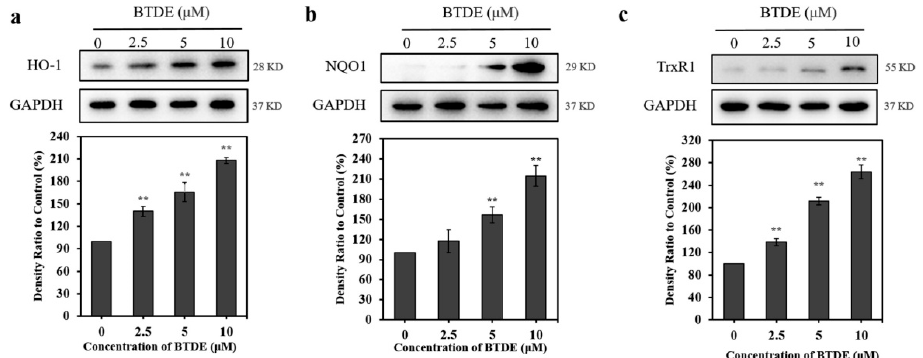
Figure 6. BTDE increases the expression of HO-1, NQO1, and TrxR1. HaCaT cells were treated with BTDE (2.5–10 μ M) for 24 h. The expression levels of HO-1 ( a ), NQO1 ( b ), and TrxR1 ( c ) were detected by Western blotting assay. Values are expressed as the mean ± SD of three independent experiments. ** p < 0.01, versus control group.